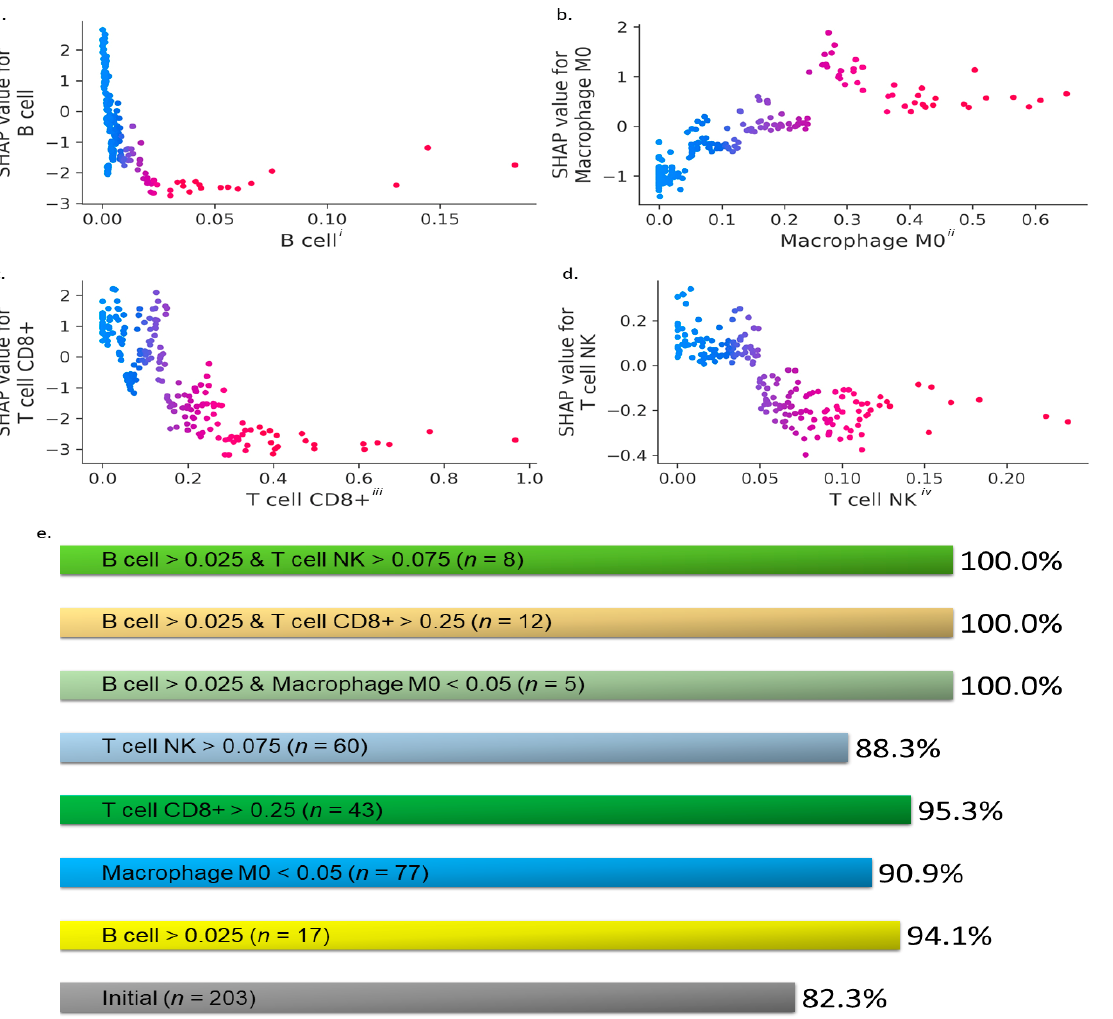
Figure 3. XAI results based on data from breast cancer patients who survived ≥ 5 years and are still alive, are dead after surviving ≥ 5 years, or are dead after surviving <5 years. The local SHAP analysis ( a – d ) reveals the interaction between B cells ( a ), M0 macrophages ( b ), CD8 + T cells ( c ), and NK T cells ( d ) (estimated using EPIC, CIBERSORT, TIMER, and xCell methods) with the ≥ 5-year survival rates, respectively. Units: i—cell fractions relative to all cells in sample, ii—immune cell fractions relative to total immune cell content, iii and iv—cancer type-specific arbitrary units comparable between samples. Lower SHAP values on the y-axis indicate higher chances of ≥ 5-year survival in breast cancer patients. The conditional probabilities of ≥ 5-year survival of all breast cancer patients in various TME conditions from the clinical dataset of patients are shown in ( e ).